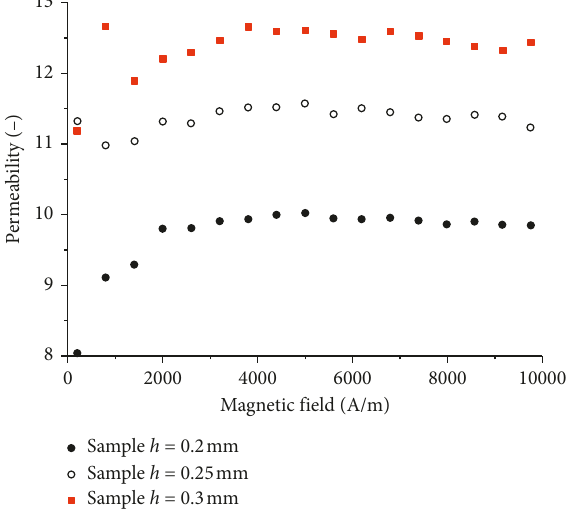
Figure 6: Magnetic permeability values for samples with different thicknesses.